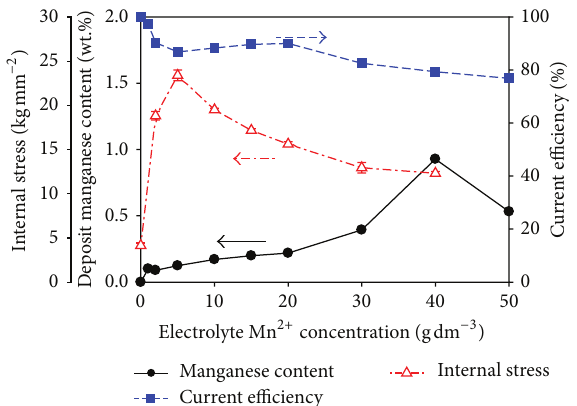
Figure 3: The influence of current density at electrodeposition on the grain size, internal stress, and hardness of the